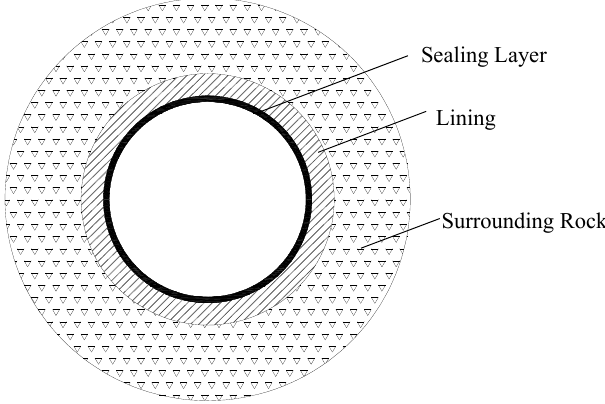
Figure 1. The structure of a compressed air energy storage (CAES) cavern.